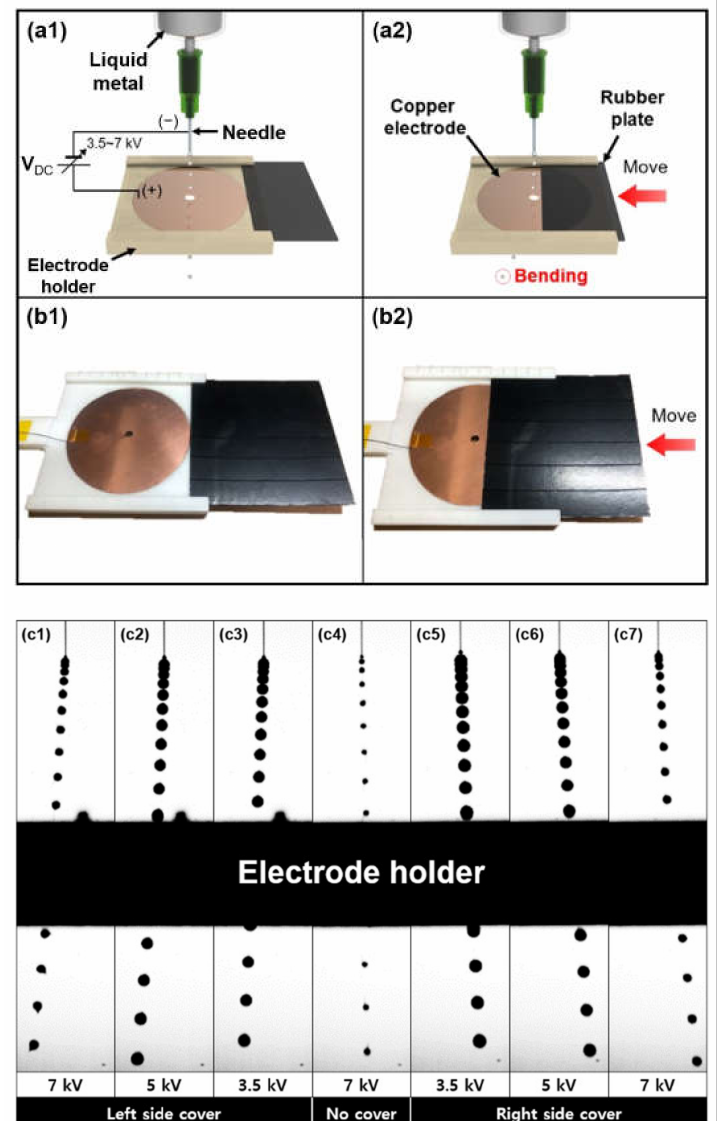
Figure 8. ( a ) Conceptual schematics and ( b ) experiment apparatus on the falling direction control of the gallium-based generated liquid metal droplet by regulating an area of the circular-shaped electrode affected by an electric field: ( a1 , b1 ) uncovered electrode and ( a2 , b2 ) covered electrode with rubber plate; ( c ) superimposed sequences for the area of the electrode-dependent falling liquid metal droplet according to various high voltages (3.5, 5, and 7 kV) (multimedia view): ( c1 – c3 ) falling of droplet in the left direction with left side cover; ( c4 ) falling of droplet in the center direction with no cover; ( c5 – c7 ) falling of droplet in the right direction with right side